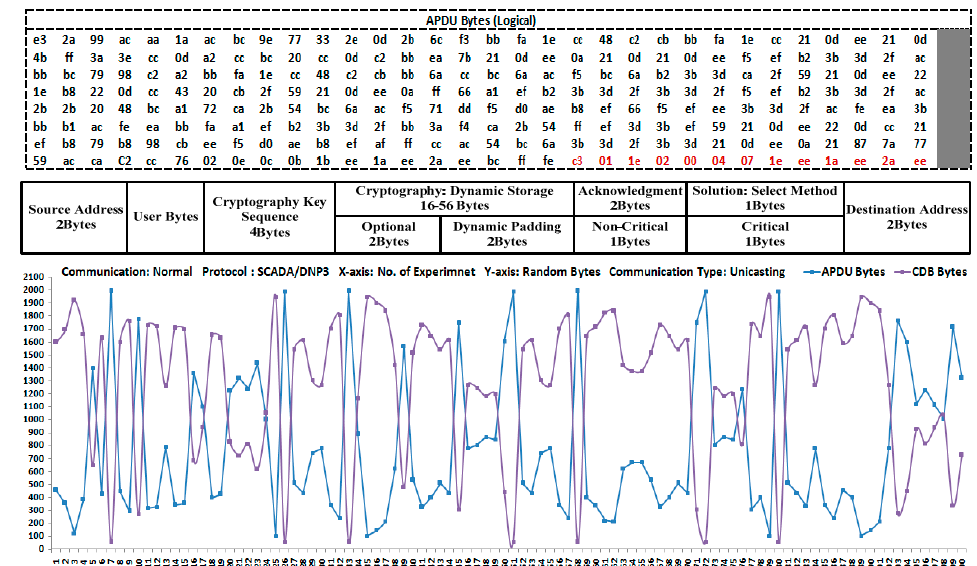
Figure 6. APDU bytes flow with the DCB interaction: At the initial stage, the number of bytes is manipulated within the application-layer stack as a part of the DNP3 protocol. The black-color bytes are designated for user-manipulated bytes, while the red-color bytes c3: Application Control (AC), 01: Function Code (FC), 1e: Group, 02: Variation, 00: Qualifer, 04: Start, 07: Stop are